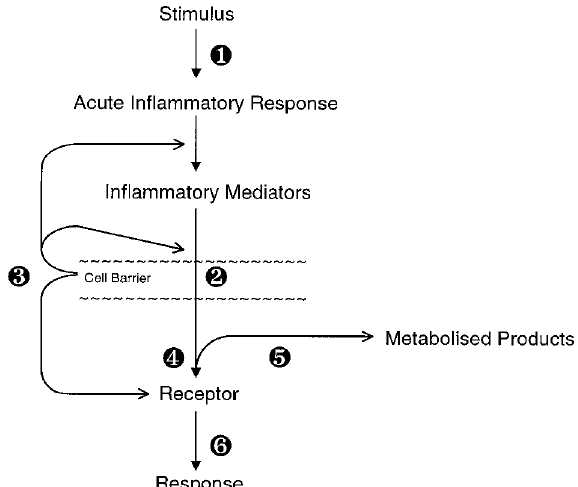
FIG. 1. Potential mechanisms in the development of AHR. ¶ Inflammatory Cascade; · altered exposure of the receptor to the stimulus; ¸ release of modulating agent by other cells; ¹ change in the receptor properties; º altered metabolism of the mediator; » altered regulation of the intracellular signal- ling resulting in the